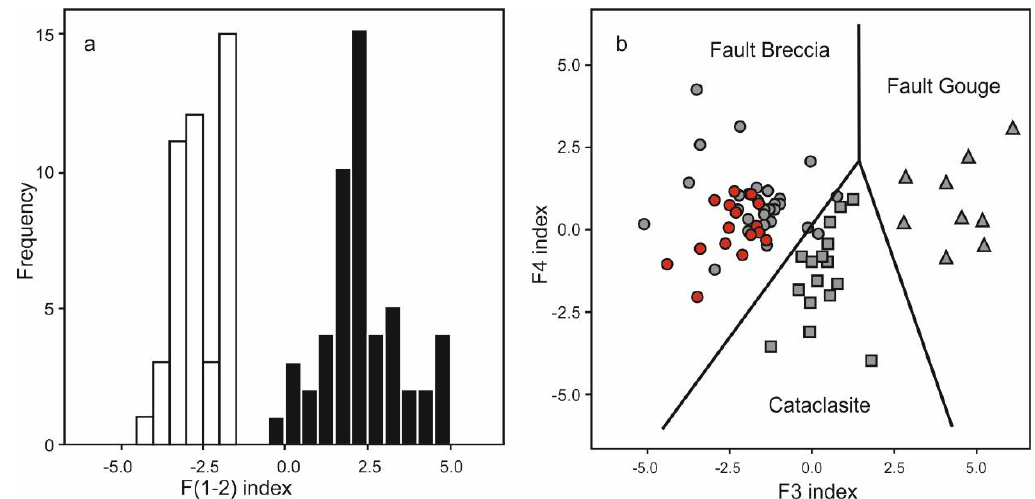
Figure 4. Discriminant functions to distinguish ( a ) undeformed host rock (white bars) from fault rocks (black bars) and ( b ) fault breccia, cataclasite and gouge based on the discriminant functions F ( 1-2 ), F3 and F4 calculated using Discriminant Function Analysis on well-log data from the Szeghalom area (modified after [19]). Red dots denote the fault rocks of the studied A-1 well.